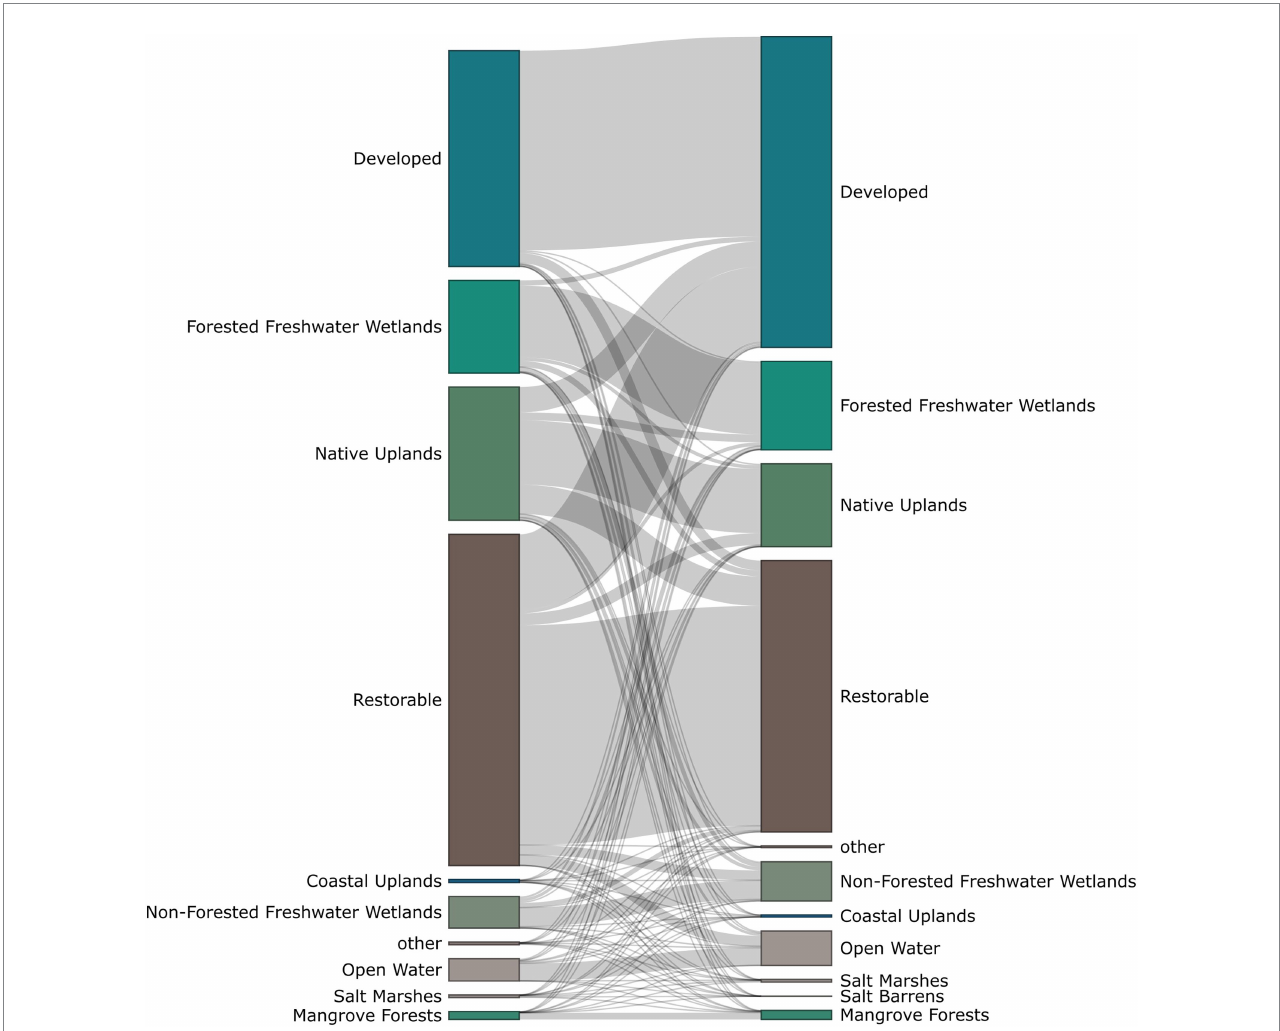
FIGURE 4 Change analysis of habitat categories in the intertidal and supratidal strata of the Tampa Bay watershed. The left column shows relative areas in 1990 and the right column shows relative areas in 2017 for each habitat category, where the bar heights are proportional to extents in each year. The grey lines show the proportional change in area of each habitat category between the